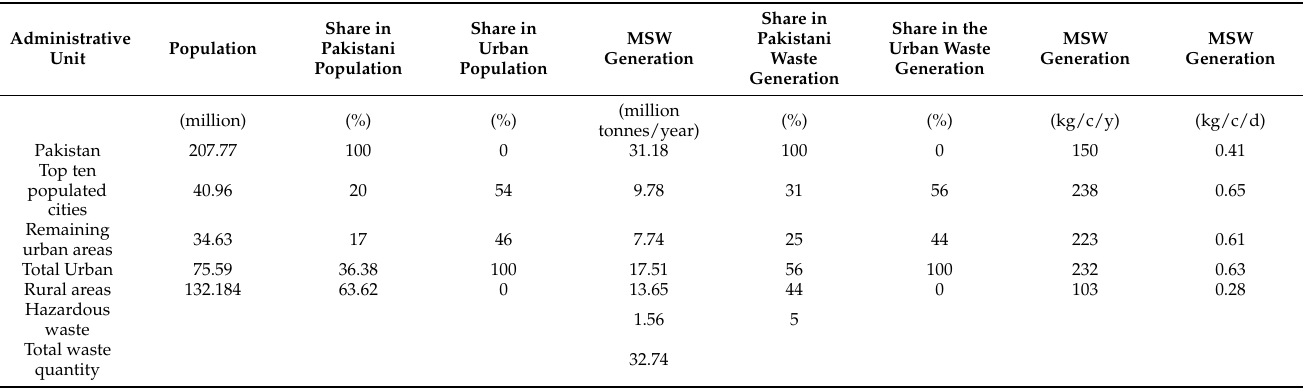
Table 3. Summary of MSW generation in Pakistan.